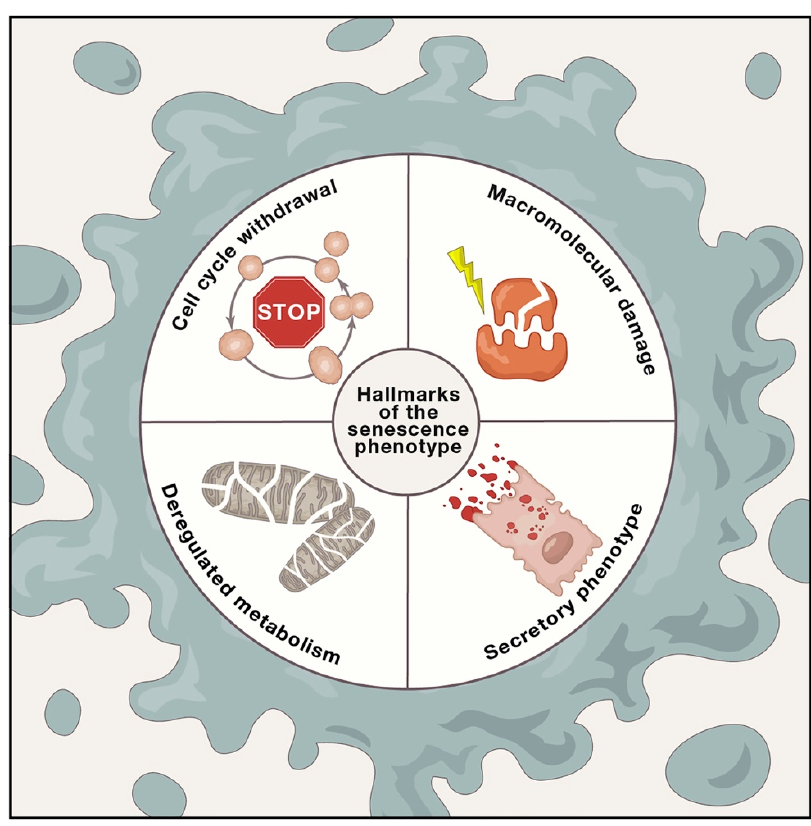
Figure 1. The Hallmarks of the Senescence Phenotype: Senescent cells exhibit the following four interdependent hallmarks: (1) cell-cycle withdrawal, (2) macromolecular damage, (3) the secretory phenotype (SASP), and (4) a deregulated metabolism (see also text). Figure reproduced with permission from Gorgoulis, V. et al.